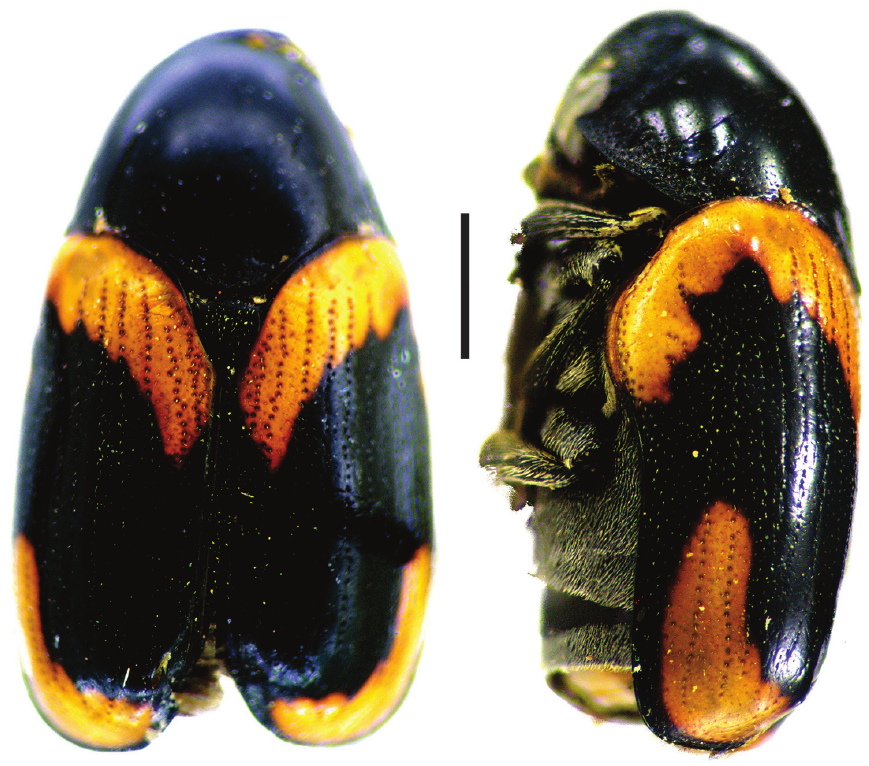
Figure 14. Temnodachrys ( Temnodachrys ) aeneofasciata (Lacordaire) (1) , left: habitus (dorsal view), right: habitus (lateral